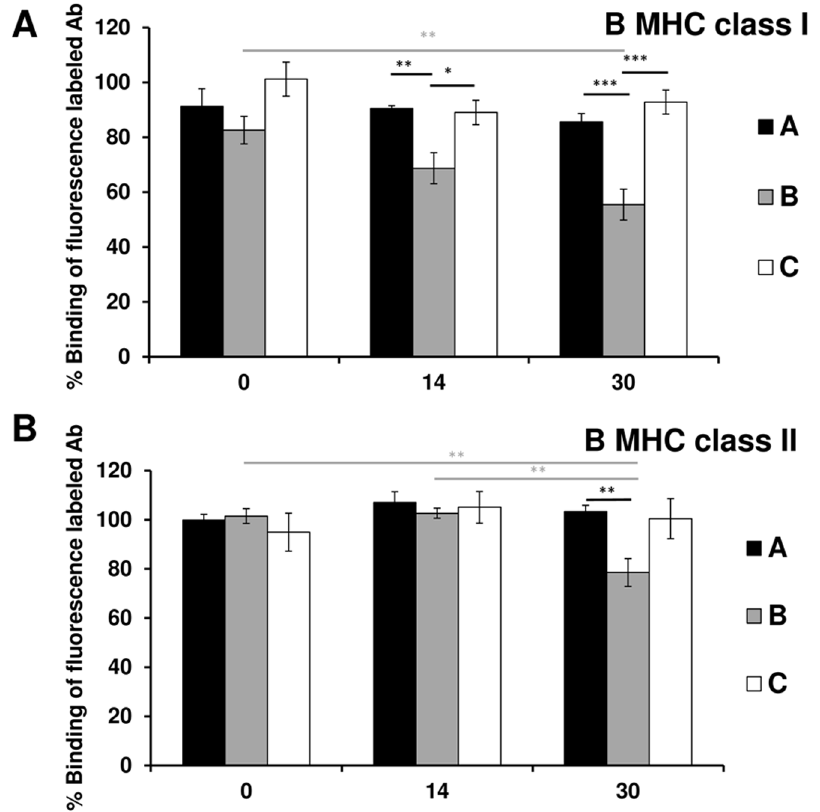
Figure 2. Dynamic of anti splenic B-cells MHC class I and II antibodies concentrations. The percentage binding of the fluorescence- labelled MHC class I (A) and MHC class II (B) antibody to BN splenic B-cells, identified as CD45RA-positive cells, in the presence of sera from group A, B, or C obtained on day 0, 14, or 30 after transplantation. Only sera from the allogeneic non-immunosuppressed group B, taken on day 14 or day 30, significantly inhibited fluorescence-labelled MHC class I and MHC class II antibody binding to splenic B-cells. Error bars represent SEM, * p , 0.05, ** p , 0.01, *** p , 0.001.